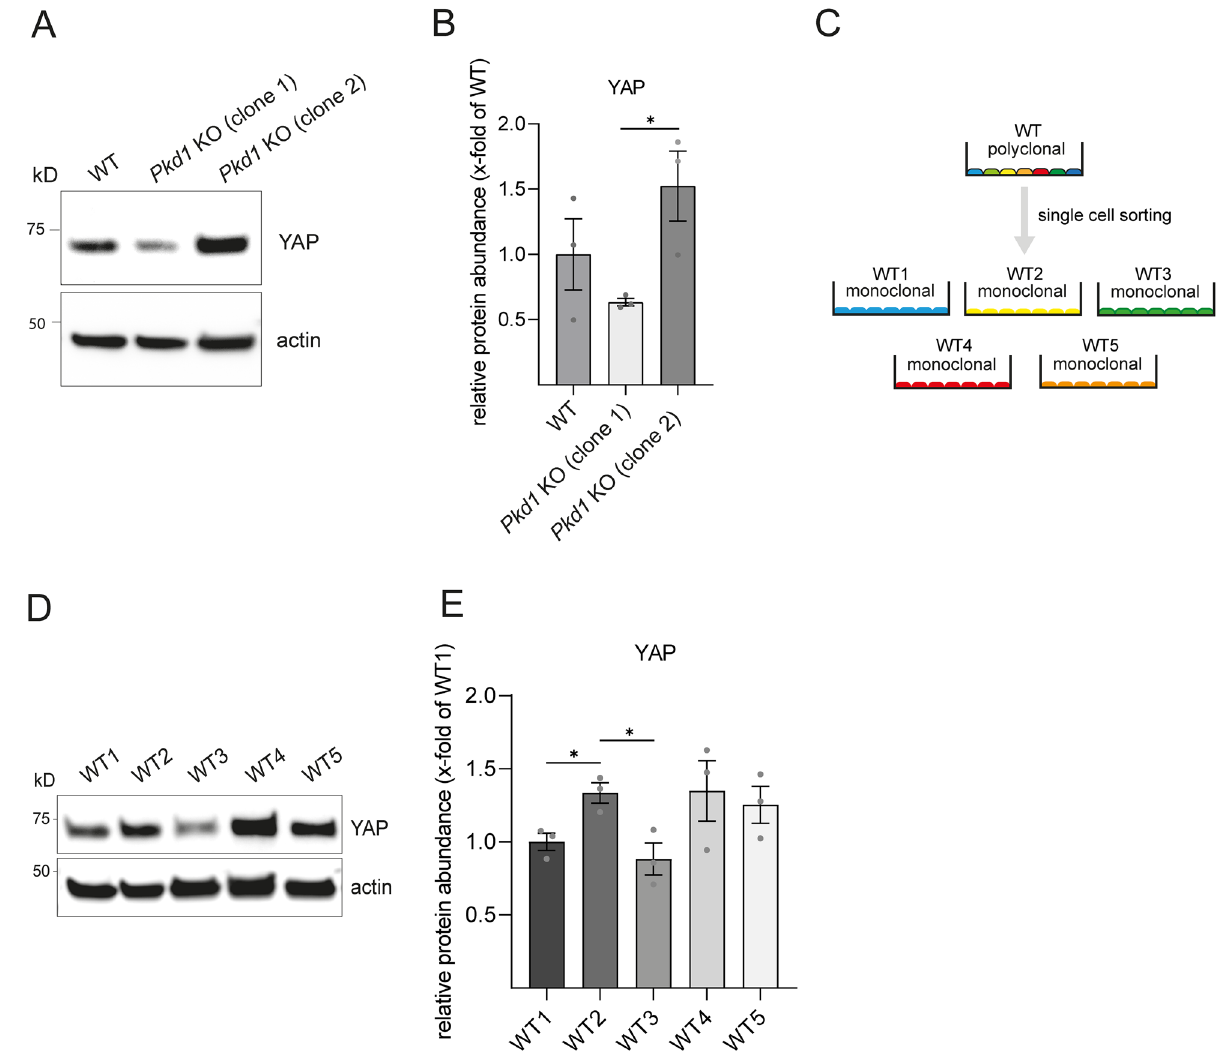
Figure 1. mIMCD-3 Pkd1 knockout clones and monoclonal mIMCD-3 wild-type clones vary in protein abundance of YAP ( A ) Protein abundance of YAP was analyzed in mIMCD-3 WT cells compared to two different Pkd1 KO clones after western blotting. ( B ) Densitometry shows significant differences in protein abundance for YAP in both Pkd1 KO clones. ( C ) WT cells were single cell sorted by FACS generating monoclonal WT cells. Five different monoclonal cell populations were arbitrarily labeled WT1–WT5. ( D ) Protein abundance of YAP was analyzed in monoclonal mIMCD-3 WT cells. ( E ) Densitometry shows varying levels of YAP with significant differences between WT1 and WT2, and WT2 and WT3, respectively. Three independent experiments were included in analysis. Error bars represent SEM. Statistical significance was evaluated using unpaired t-test. *Indicates p < 0.05. Unprocessed blots for ( A and D ) are presented in Supplementary Figs. S6 and function in 3D cell cultures with polyclonal cell lines can be biased by heterogeneity of WT cells resulting in misinterpretation of gene deletion effects after isolation of subclones. In summary, different WT subclones derived from the same well-characterized mIMCD-3 cell line show remarkably different characteristics regarding abundance of proteins, drug susceptibility and morphological patterns in 3D cell cultures. We thus concluded that WT heterogeneity might be a driver for phenotypic vari- ability of genome-edited cell lines. This led us to modify our genome editing protocol and introduce an initial single cell sorting step to generate monoclonal WT cell lines prior to transfection of gRNAs and Cas9 (Sup- plementary Fig. S3). KO clones derived from monoclonal isogenic wild-type cells show less variability and differ- ences in protein levels compared to polyclonal KO clones. Using this modified genome editing workflow, we generated monoclonal Pkd1 KO clones from a matched isogenic WT control cell line. In the fol- lowing, we refer to these cells as monoclonal Pkd1 KO cells. Cell lines generated from polyclonal parental cells